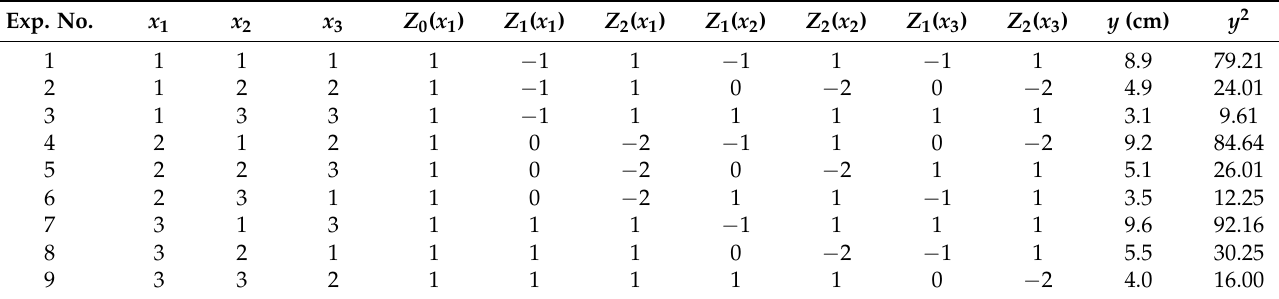
Table 4. Design and results of orthogonal polynomial regression experiment.